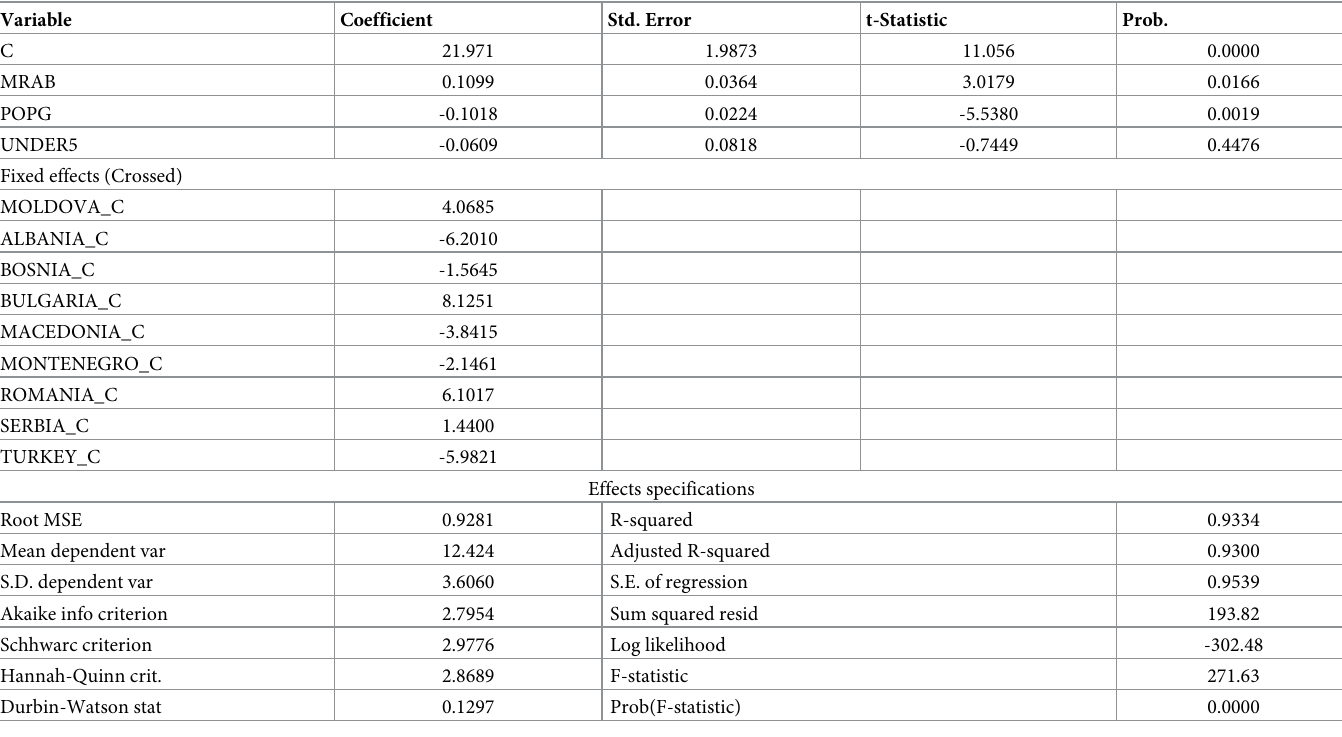
Table 1. Estimation results for the pooled series with cross-section fixed